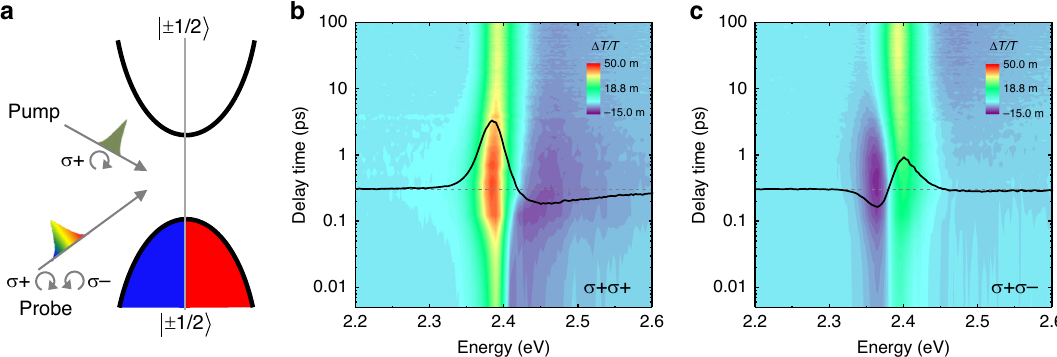
Fig. 1 Spin-dependent optical nonlinearities in CsPbBr 3 at room temperature. a Schematics of the resonant pumping and broadband-probing transient absorption (TA) spectroscopy and the electronic band structure of CsPbBr 3 . The doubly degenerate spin states at the conduction band minimum or valence band maximum have angular momentum ±1/2. The laser beam with right ( σ + ) or left ( σ − ) circular polarization can generate exciton states with total angular momentum + 1 or − 1. b , c Time evolution of TA spectra of CsPbBr 3 obtained with co-circularly ( σ + σ + ) and cross-circularly ( σ + σ − ) polarized pump and probe pulses, respectively, at room temperature. The black curves in b and c show the TA spectra at a delay time of 0.3 ps, and the associated horizontal gray dashed lines are baselines with Δ T / T = 0. The photon energy of pump beam is ~2.4 eV, which is in resonant with the exciton states. The pump fl uence is ~0.9 μ J/cm 2